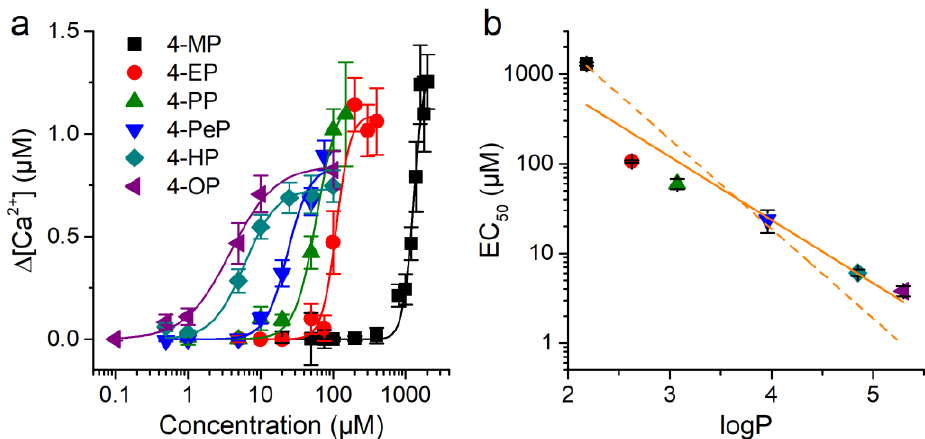
Figure 6. mTRPA1 activation by alkylphenols correlates with compound lipophilicity. ( a ) Concentration-dependent responses of mTRPA1 to APs from which compounds EC 50 values were determined. Data from > 50 cells shown as mean ± s.e.m. ( b ) Relationship between the EC 50 for mTRPA1 activation and logP across APs. The lines represent fittings with linear functions with slope constrained to − 1 (dashed) or the best fit with unconstrained slope (continuous) (see text for more details).